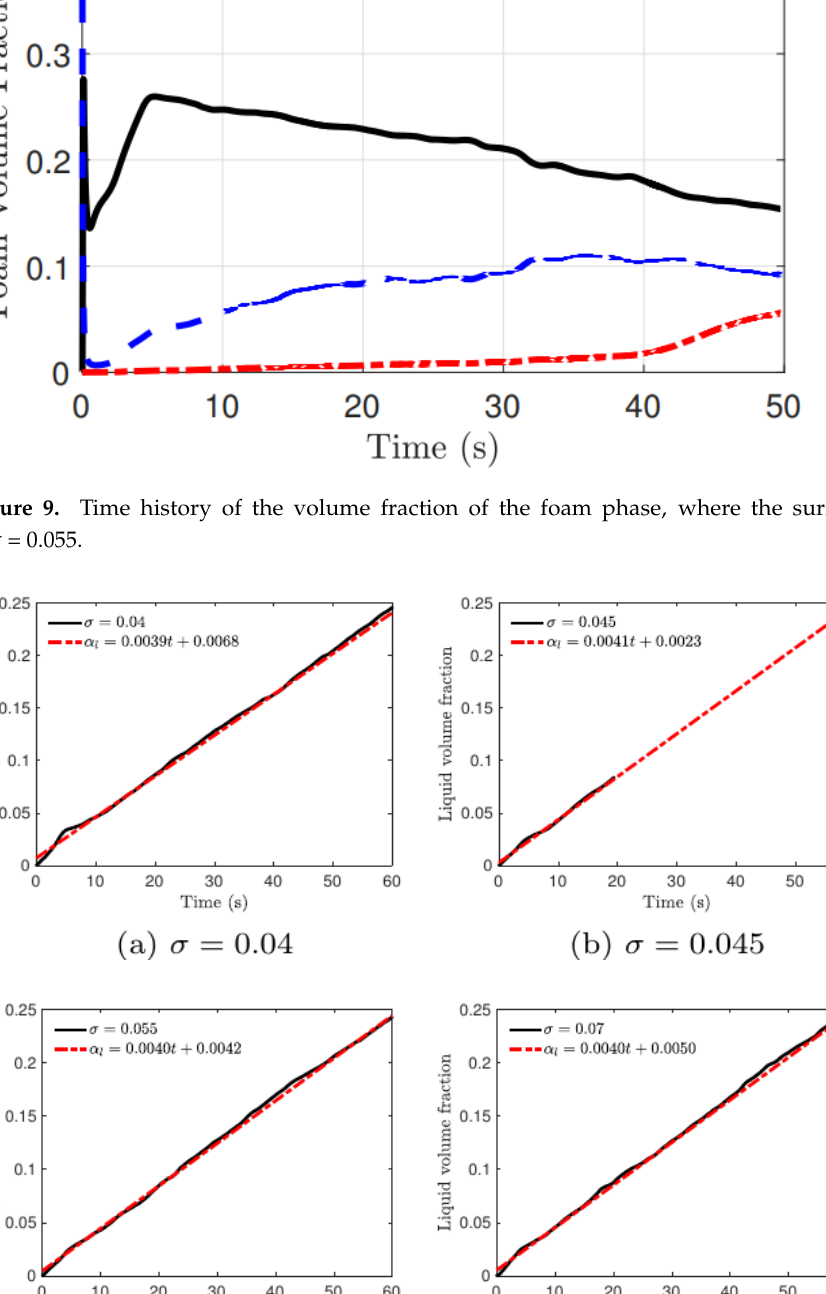
Figure 9. Time history of the volume fraction of the foam phase, where the surface tension is σ = 0 . 055.